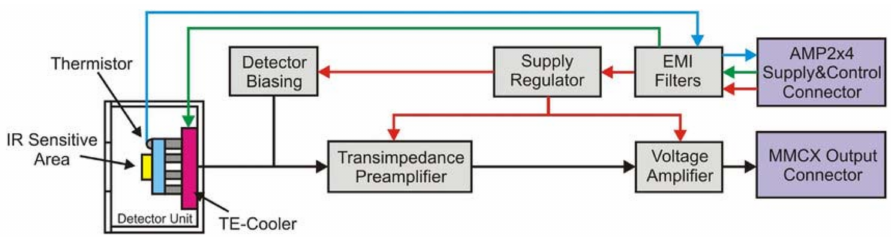
Figure 4. Characteristics of pulsed QC laser (#356).